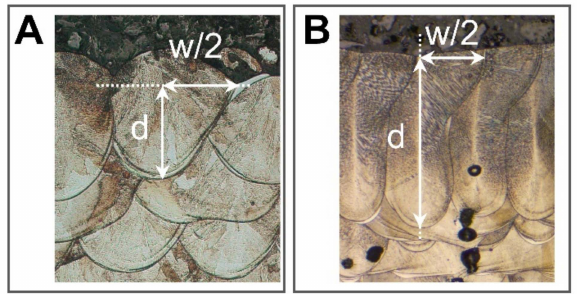
Figure 1. Schematic illustration of the method applied for measuring melt pool depth (d) and halfwidth (w/2) in melt pools characteristic of ( A ) conduction and ( B ) keyhole melting. Melt pool monitoring was performed during the entire build process utilizing EOSTATE Melt Pool monitoring (Electro Optical Systems GmbH, Krailling, Germany). The setup consists of a photodiode mounted on-axis, coaxially with the laser beam, with bandwidth 450 nm–850 nm, i.e., in the visible and near-infrared spectra. The signal is acquired in the time domain at 60 kHz but is also translated to spatial coordinates, allowing enhanced data visualization. Signal processing was performed in the time domain within